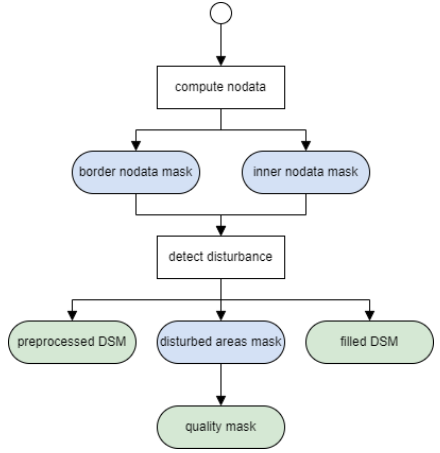
Figure 5. Bulldozer pre-processing simplified pipeline chart (Blue: intermediate products, Green: outputs).